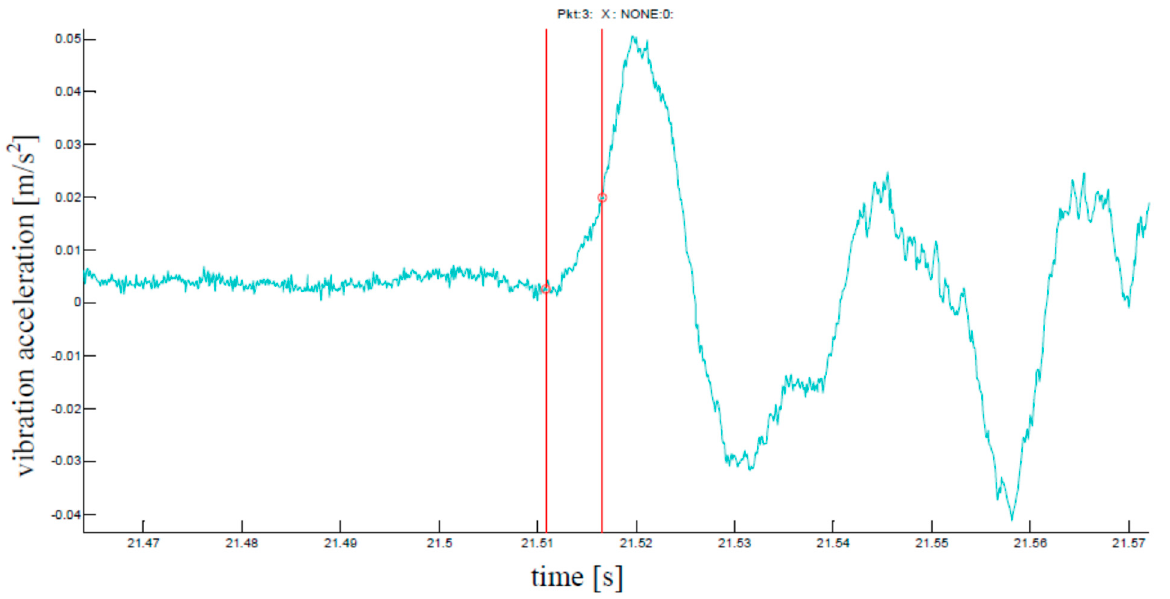
Figure 7. Time instants associated with the beginning of the response signal amplitude that increase and reach the assumed reference level.